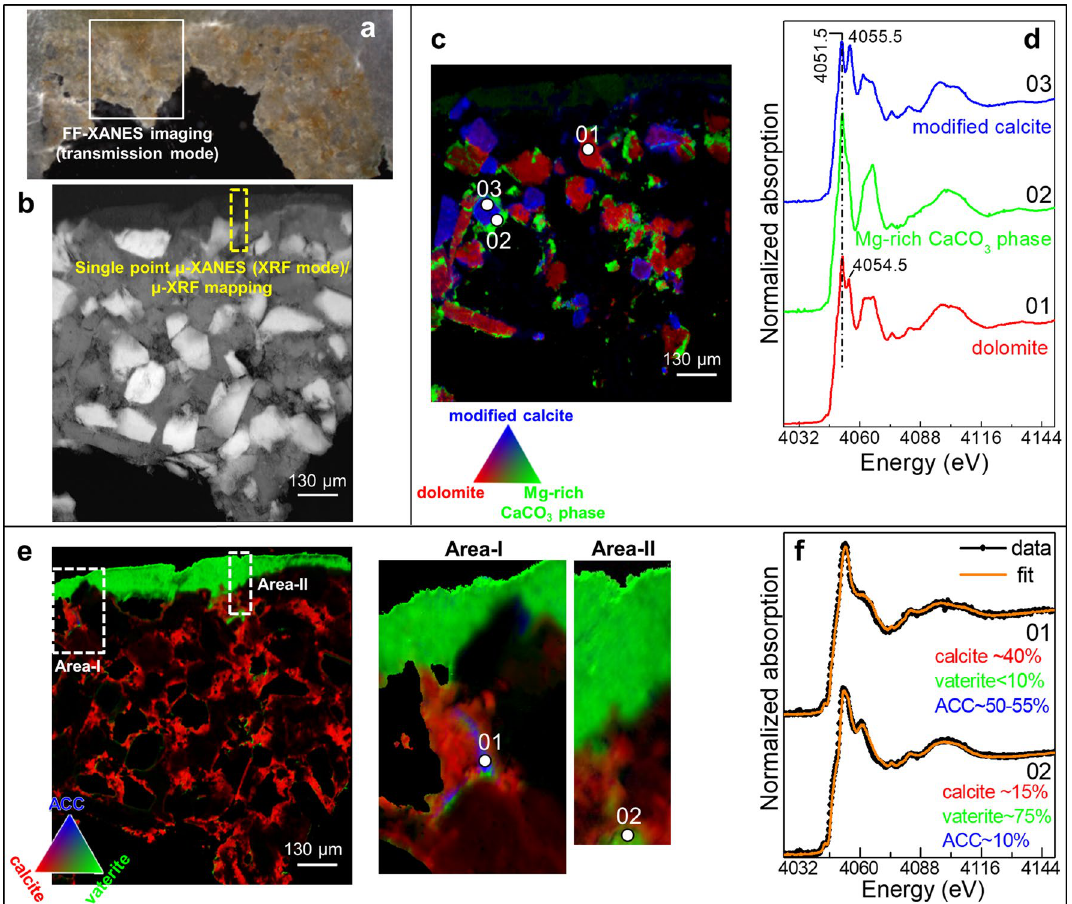
Figure 3. (a) Microphotograph of the cross-section L 1 (~ 80 µm in thickness) obtained from the Lecce stone mock-up consolidated with CFW (RH = 50%, T = 40 °C, 5 months). (b) Transmission image recorded at 3,918 eV from the area shown in (a) . RGB Ca phase maps of (c) dolomite/Mg-rich CaCO 3 phase/modified calcite and (e) calcite/vaterite/ACC [FOV: ~ 1,000 × 1,000 µm 2 ; pixel sizes (h × v): ~ 0.65 × 0.65 µm 2 ]. (d,f) Ca K-edge XANES spectra (black) extracted from regions of interest of the FF-XANES stack shown in (c,e) (average pixel number: 5–20) and corresponding LSLC fit result of different Ca-based compounds (orange). Data were processed by employing TXM-Wizard 40